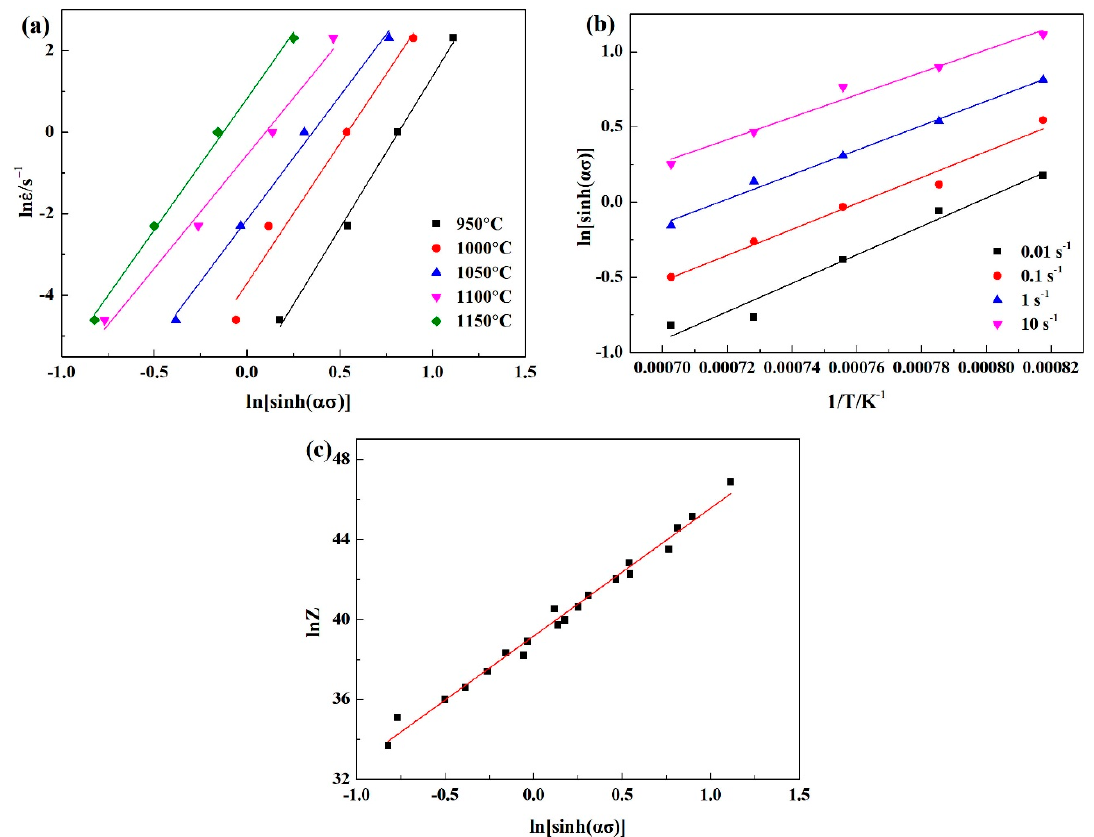
. ε Figure 6. Linear relationships between ( a ) lnsinh( ασ ) and ln ε(cid:4662) under different deformation Figure 6. Linear relationships between ( a ) lnsinh( ασ ) and ln under di ff erent deformation temperatures, temperatures, ( b ) 1/T and lnsinh( ασ ) at different strain rates and ( c ) lnsinh( ασ ) and ln Z . ( b ) 1 / T and lnsinh( ασ ) at di ff erent strain rates and ( c ) lnsinh( ασ ) and ln Z